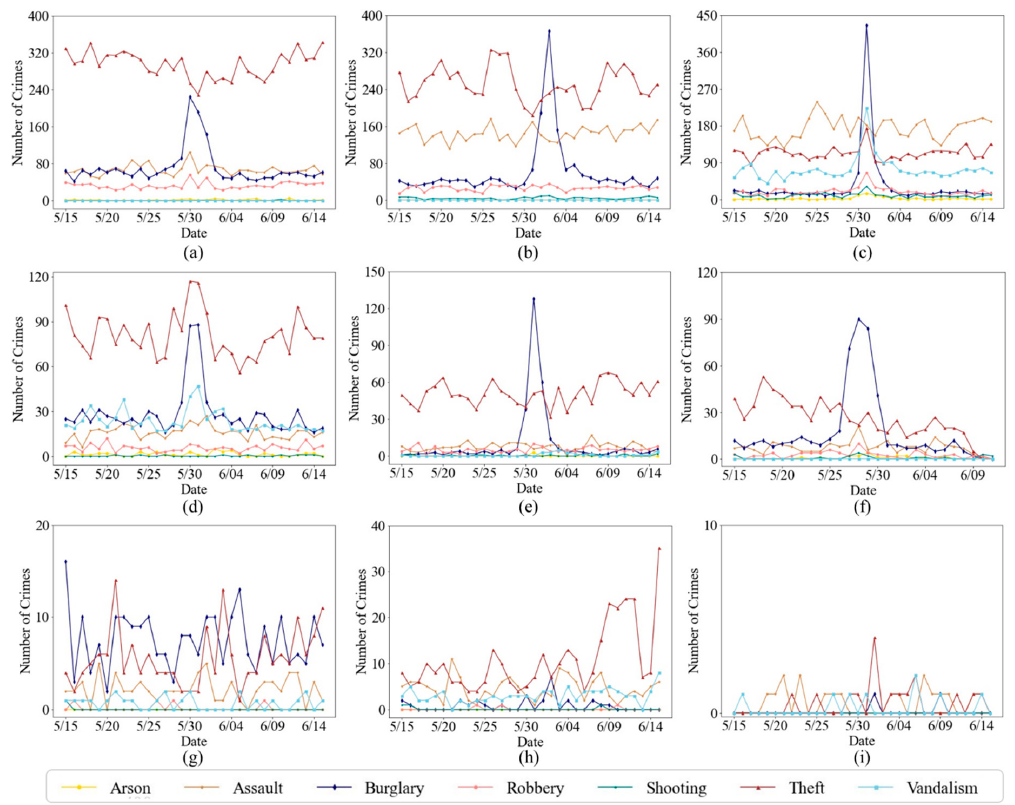
Figure 5. Number of crimes for different types ( a ) Los Angeles County, CA; ( b ) New York City, NY; ( c ) Chicago, IL; ( d ) San Francisco; ( e ) Washington D.C.; ( f ) Minneapolis, MN; ( g ) Shelby County, AL; ( h ) Olmsted County, MN; ( i ) Newberry County, SC.